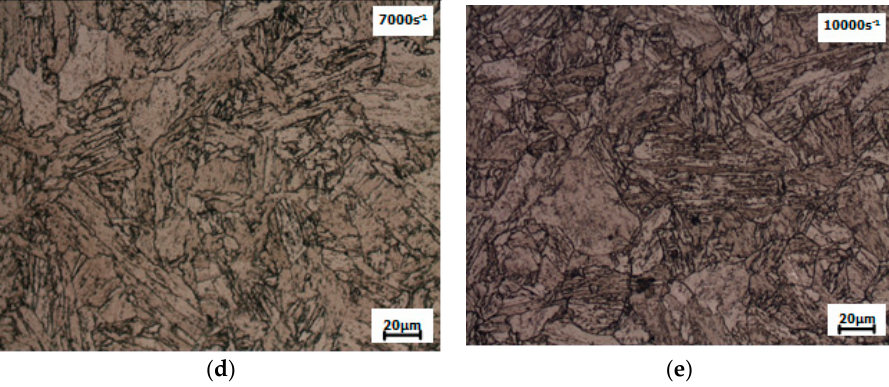
Figure 6. True stress–strain curves ( a ) and its corresponding optical photomicrographs of SHPB tested samples deformed at 600 °C with strain rate ( b ) 1000 s − 1 ; ( c ) 4000 s − 1 ; ( d ) 7000 s − 1 and ( e ) 10,000 s − 1 .